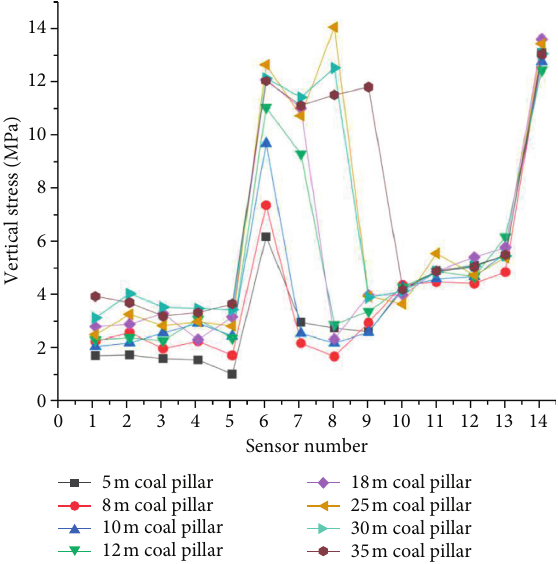
Figure 12: Floor pressure distribution curve.